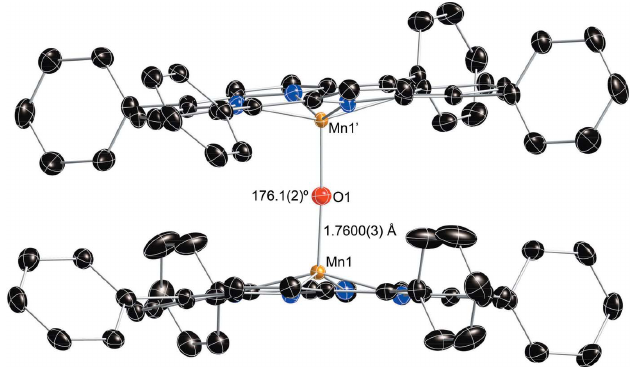
Figure 1 Edge-view of the dinuclear complex of the title compound with displacement elliposids drawn at the 50% probability level. Hydrogen atoms are omitted for clarity.